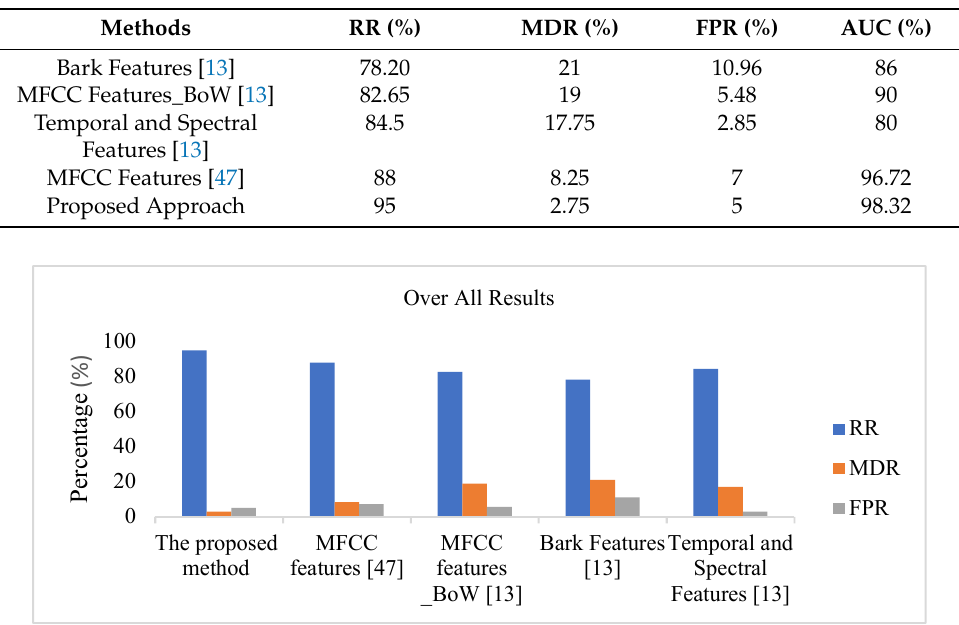
Table 5. Comparison of performance results between the proposed approach and other approaches.